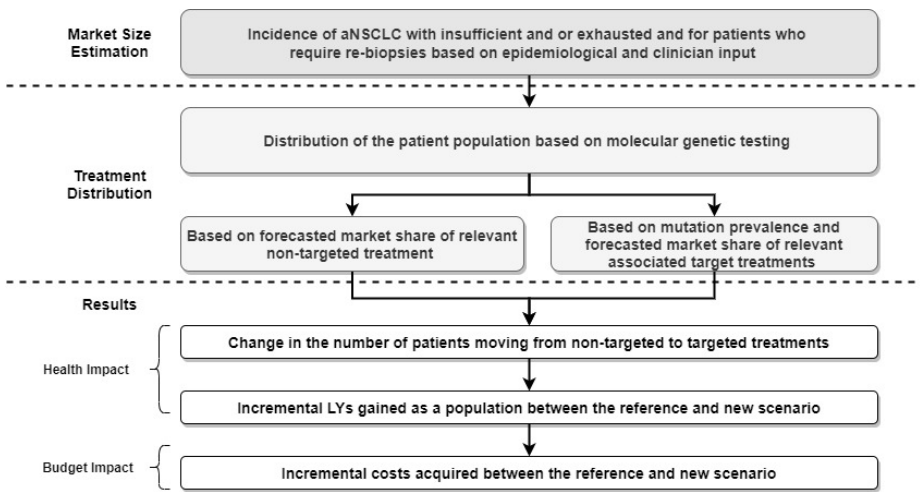
Figure 1. Health and budget impact model overview.